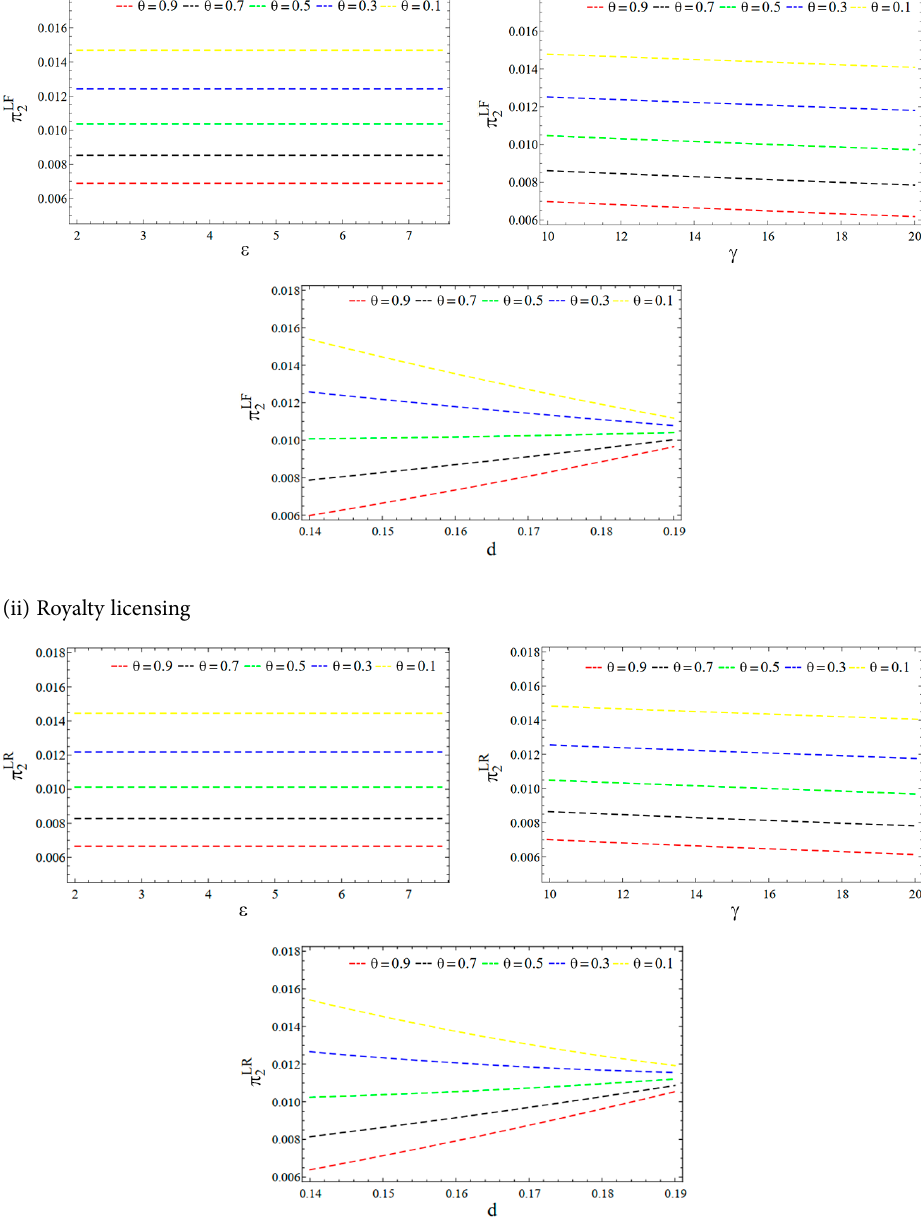
Figure 5. Analytical sensitivity on ( ) 2 LR F π with different